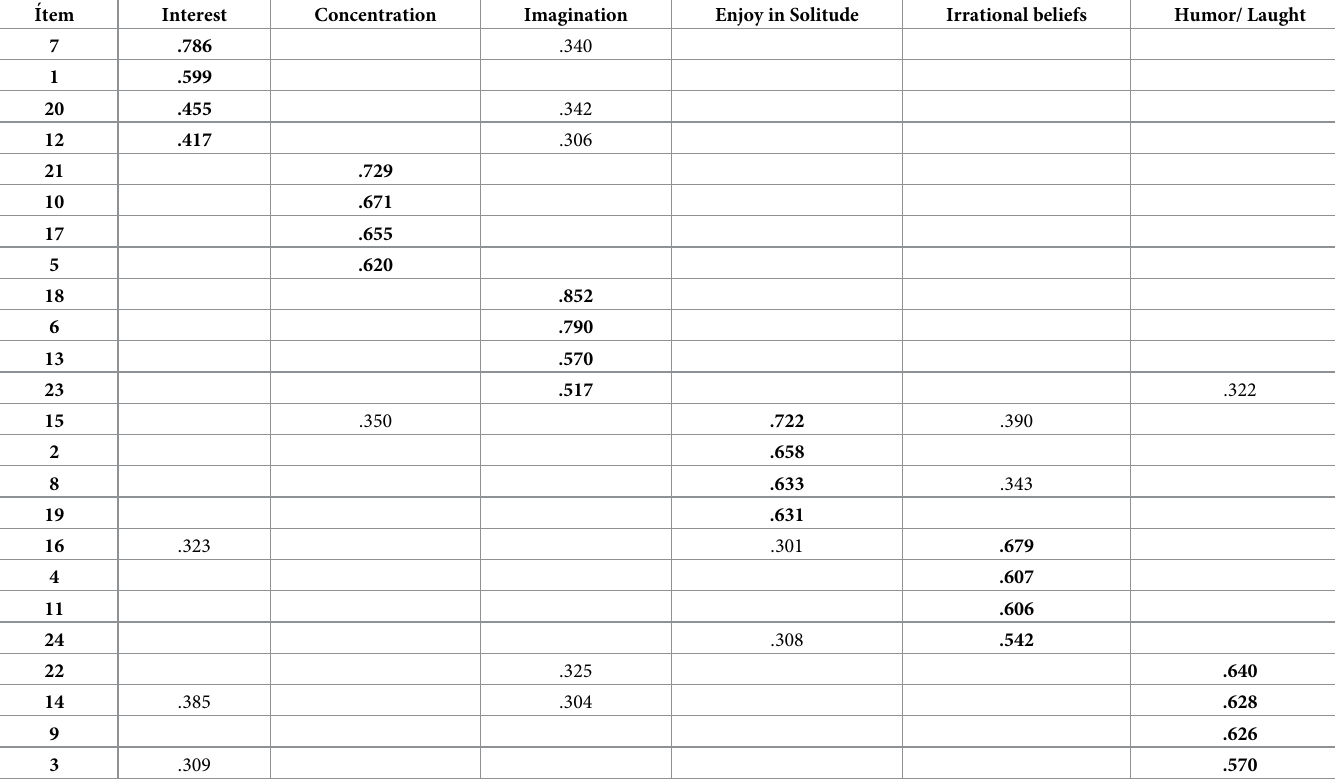
Table 2. Rotated component matrix after confirmatory factor